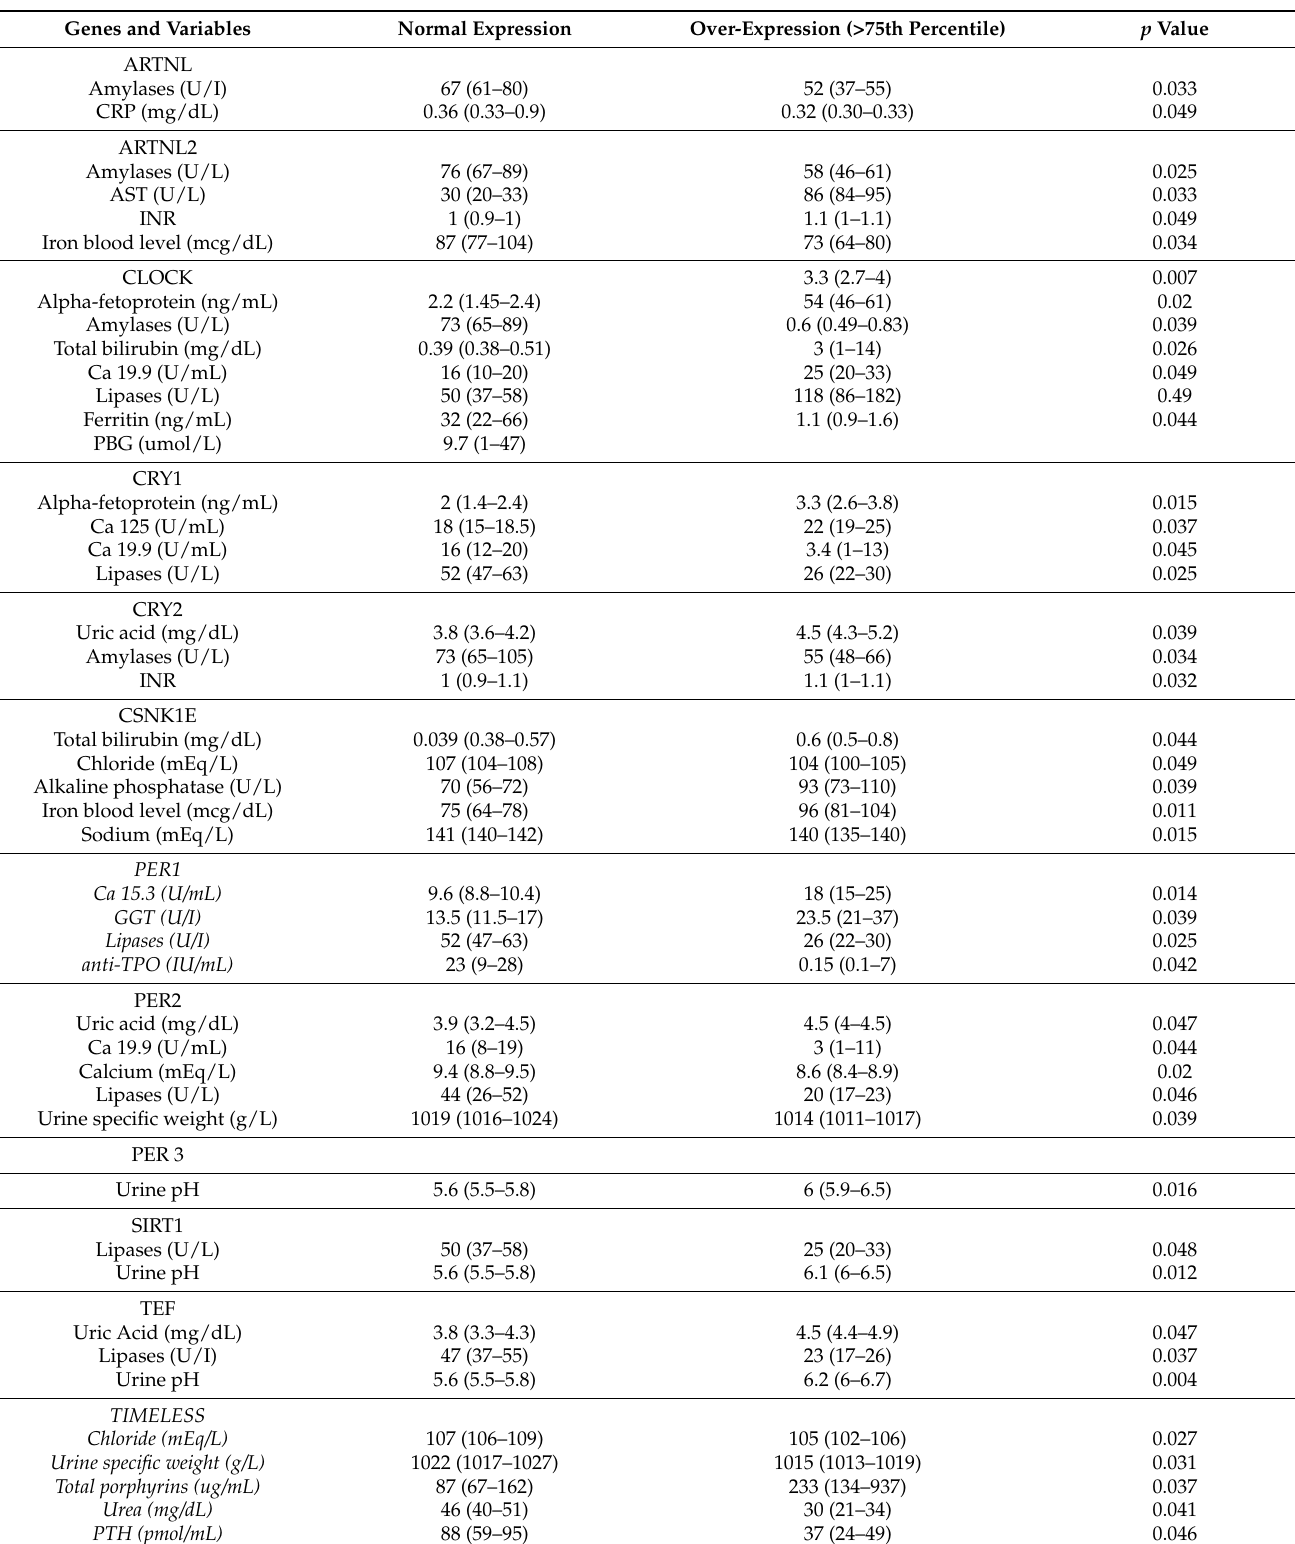
Table 5. Laboratory characteristics found significantly different between porphyria patients with normal expression and porphyria patients with over-expression of circadian